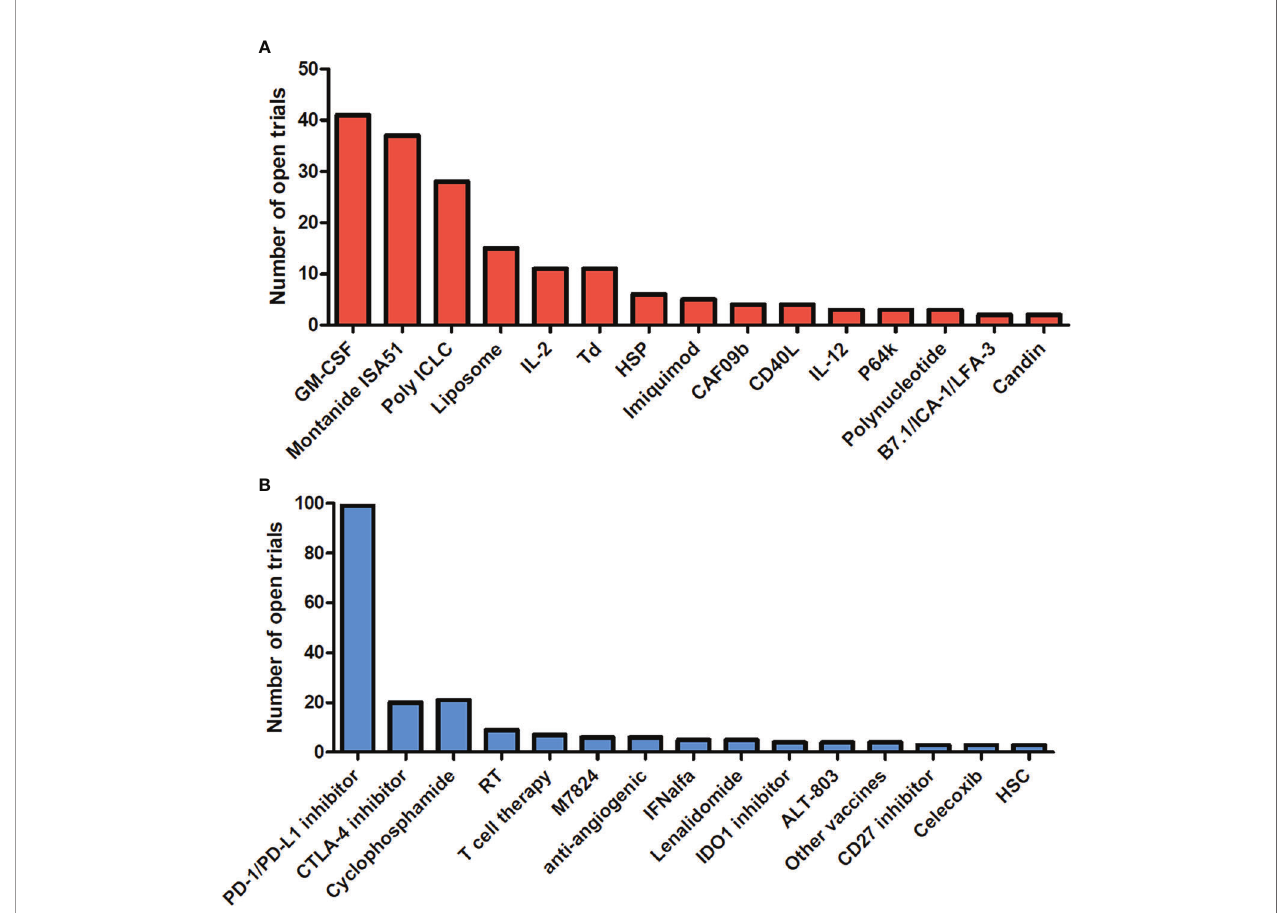
FIGURE 2 | Adjuvants and combinatorial immunomodulatory therapies being used in cancer vaccine trials. Cancer vaccine trials listed as open at ClinicalTrials.gov on August 2020. The number of trials using each adjuvant (A) and associating each immunomodulatory therapy with the cancer vaccine (B) are shown in the bar graph. Adjuvants and combinatorial therapies used in less than 2 clinical trials are not shown. GM-CSF, Granulocyte-macrophage colony-stimulating factor; IL-2, interleukin-2; Td, Tetanus/diphtheria toxoid; HSP, heat shock protein; CAF09b, cationic liposomes (DDA-MMG1) with complex bound synthetic double-stranded RNA (Poly(I:C)2); IL-12, Interleukin- 12; P64k, Neisseria meningitides protein; PD-1, Programmed cell death 1; PD-L1, Programmed cell death ligand 1; CTLA-4, cytotoxic T-lymphocyte-associated protein 4; RT, radiotherapy; M7824, fusion protein composed of a human IgG1 monoclonal antibody against PD-L1 fused with 2 extracellular domains of TGF- b RII; IFNalfa, Interferon alfa; IDO1, indoleamine 2,3-dioxygenase 1; ALT-803, IL-15 superagonist; Other vaccines, Salmonella, pneumococcal vaccines; HSC, hematopoietic stem